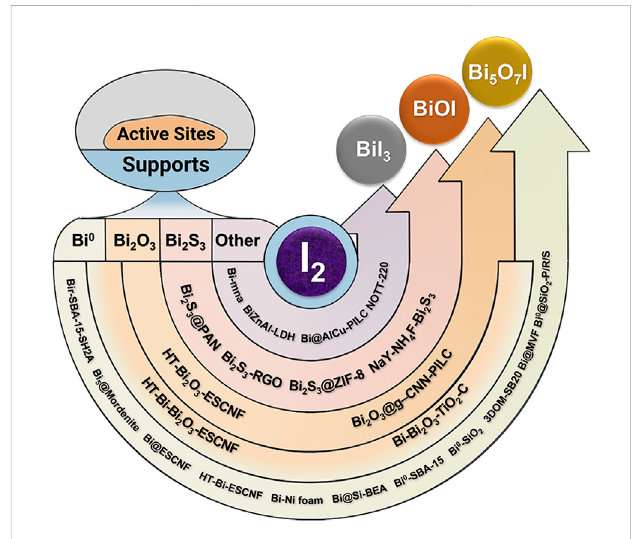
FIGURE 1 Overview of Bi-based materials for gaseous iodine